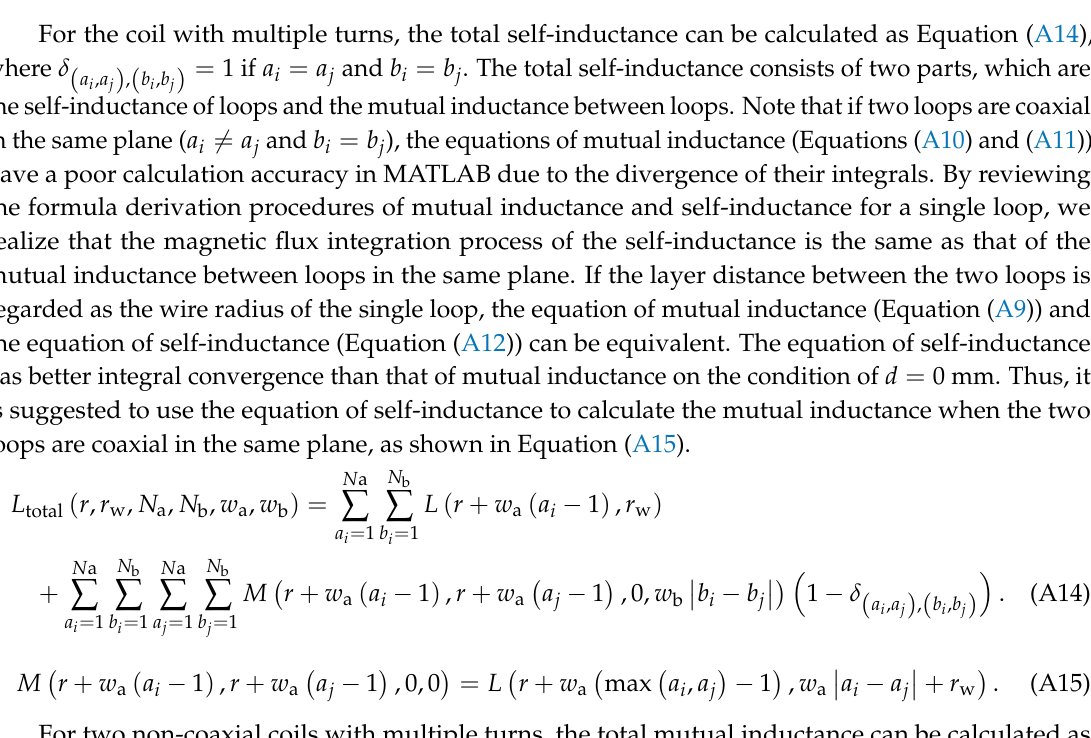
Figure A2. Geometric arrangement and notation of the coil with multiple